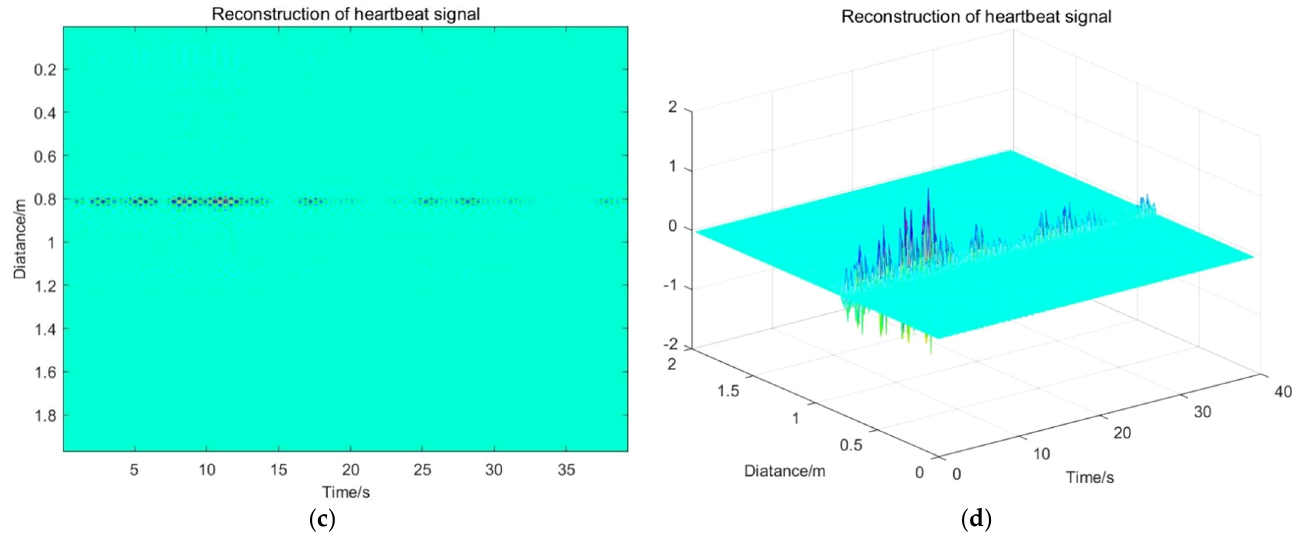
Figure 24. Vital signs reconstruction results: ( a ) Reconstruction of respiratory signal; ( b ) Three-dimensional display of respiratory signal; ( c ) Reconstruction of heartbeat signal; ( d ) Three-dimensional display of heartbeat signal. Table 4. Results and performance of the proposed algorithm.